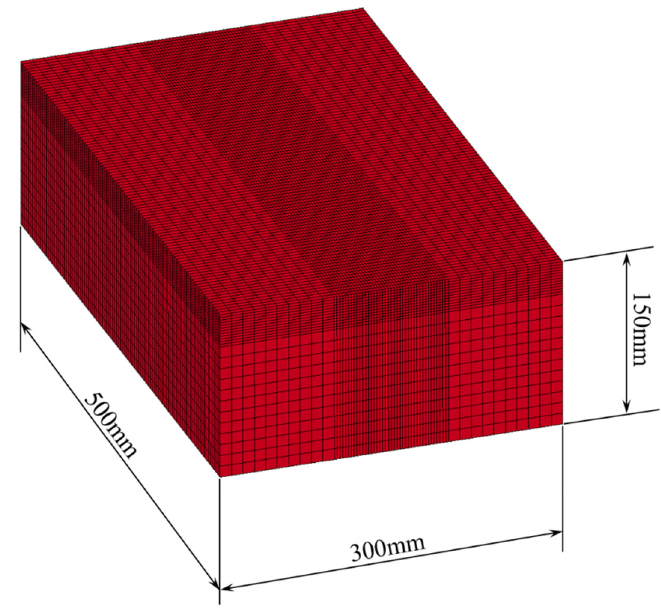
Figure 8. Schematic diagram of rock materials. Table 3. Diorite’s HJC model characteristic